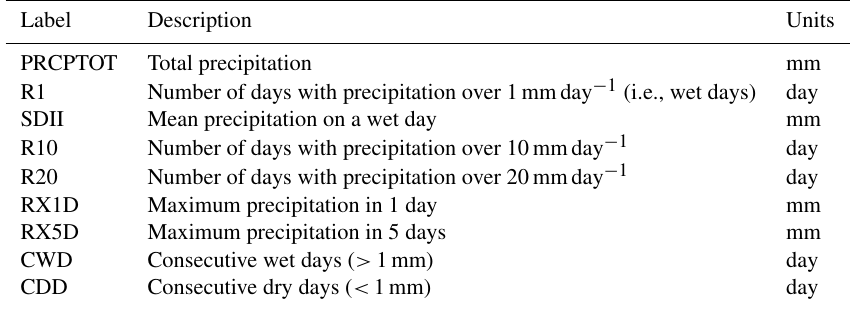
Table 1. The climatic mean and extreme indices for the precipitation used in this work based on ETCCDI (Expert Team on Climate Change Detection and Indices; http://cccma.seos.uvic.ca/ETCCDI).